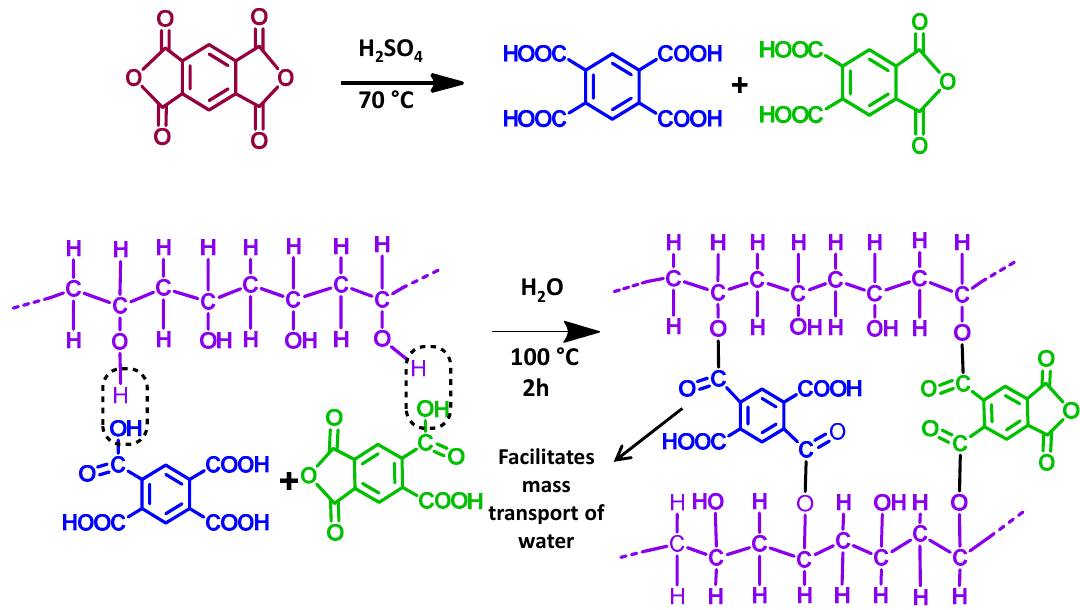
Figure 3. Crosslinking reaction during PMDA crosslinked PVA fabrication.